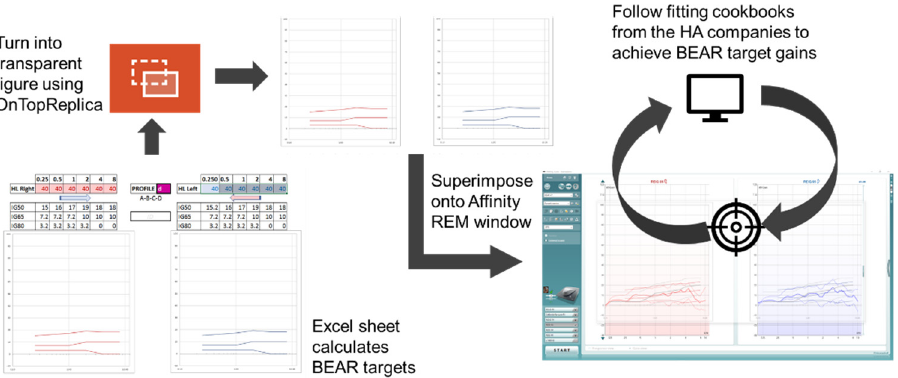
Figure 2. Illustration of the BEAR fitting tool and procedure developed for the clinical study.